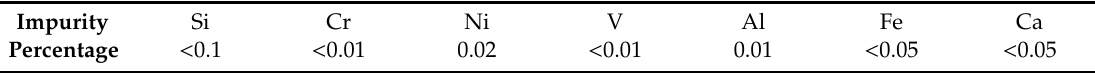
Table 2. Percentage present of impurities within the MgO ball-milled sample measured using ICP-MS. Impurity